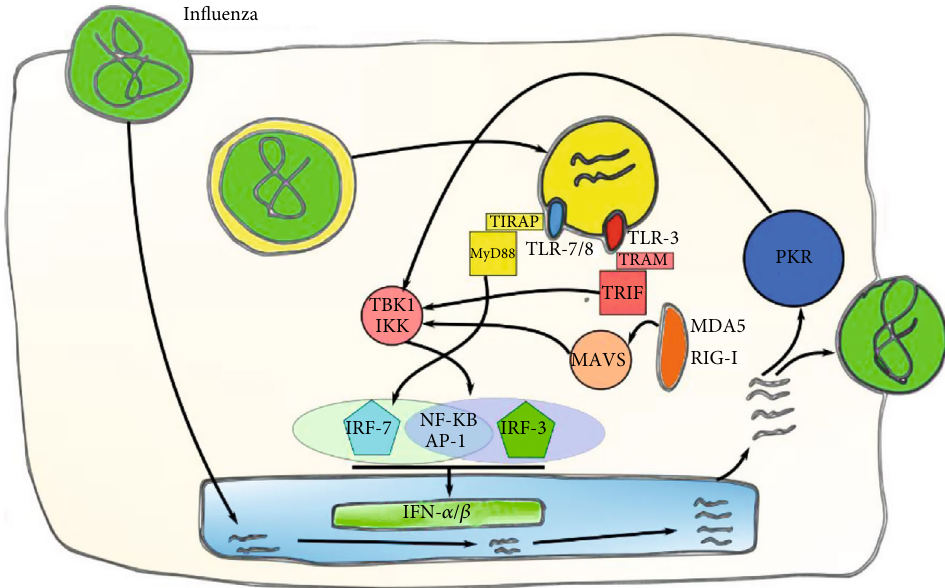
Figure 2: Induction of IFN-I by in fl uenza virus. PRRs involved in viral recognition include TLR-3, TLR-7/8, MDA5, and RIG-I that can detect viral products to signal IFN- α / β production in infected